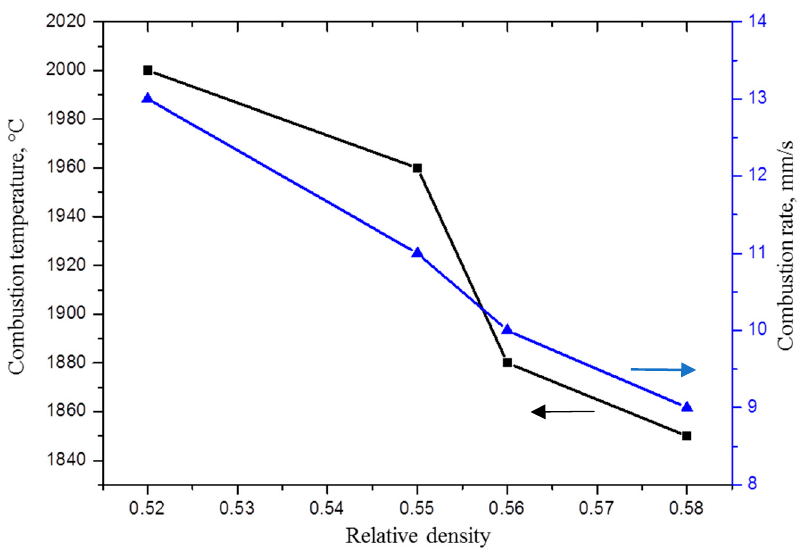
Figure 1. Temperature and rate of combustion vs. the relative density of a charge sample.